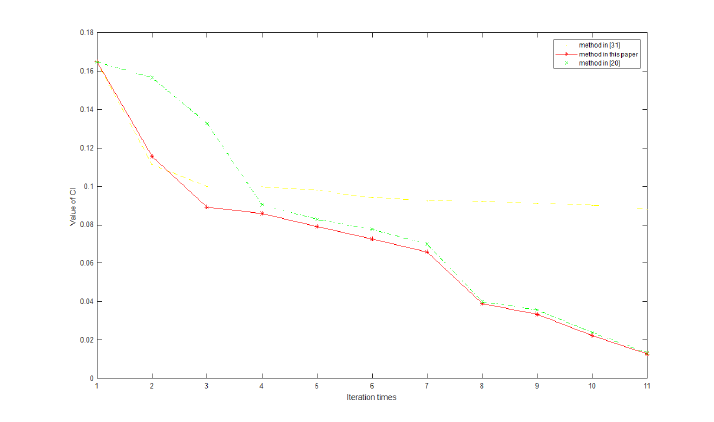
Figure 6. Comparison diagram of three consistency improvement